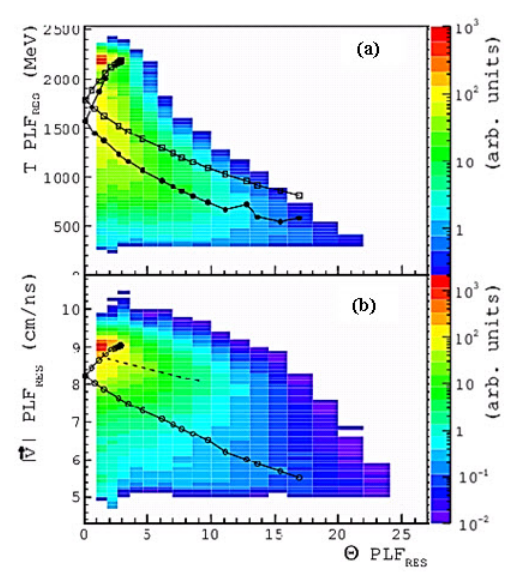
Figure 1: Experimental Wilczy´nski contour diagrams for the reaction 48 Ca+ 124 Sn at E/A=45 MeV. Top: PLF energy vs. angle, bottom: PLF velocity vs. angle. Symbols and curves represent mean predictions by the nucleon exchange model (CLAT). See